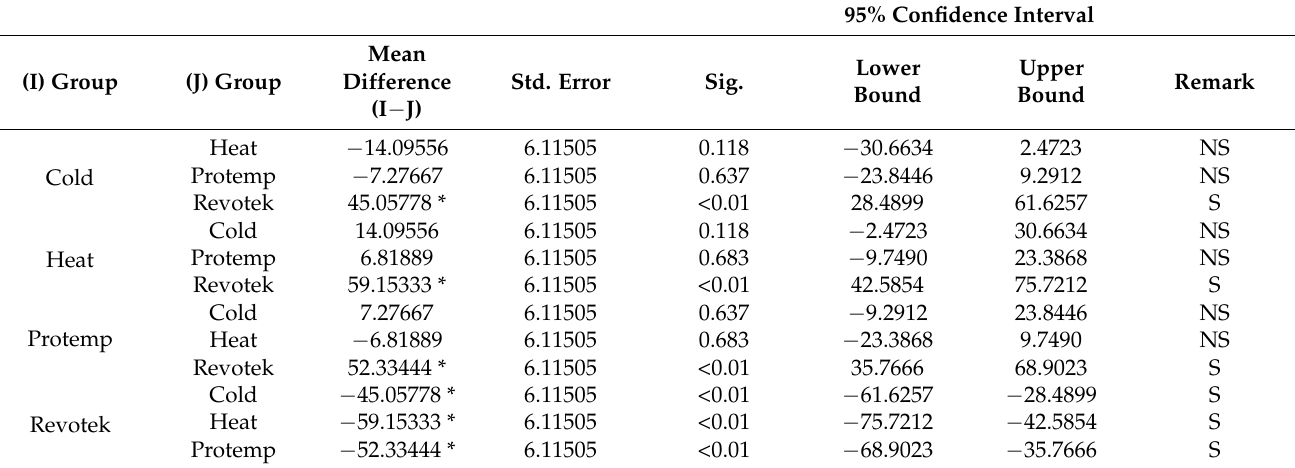
Table 2. Analysis using post hoc tests (Tukey).